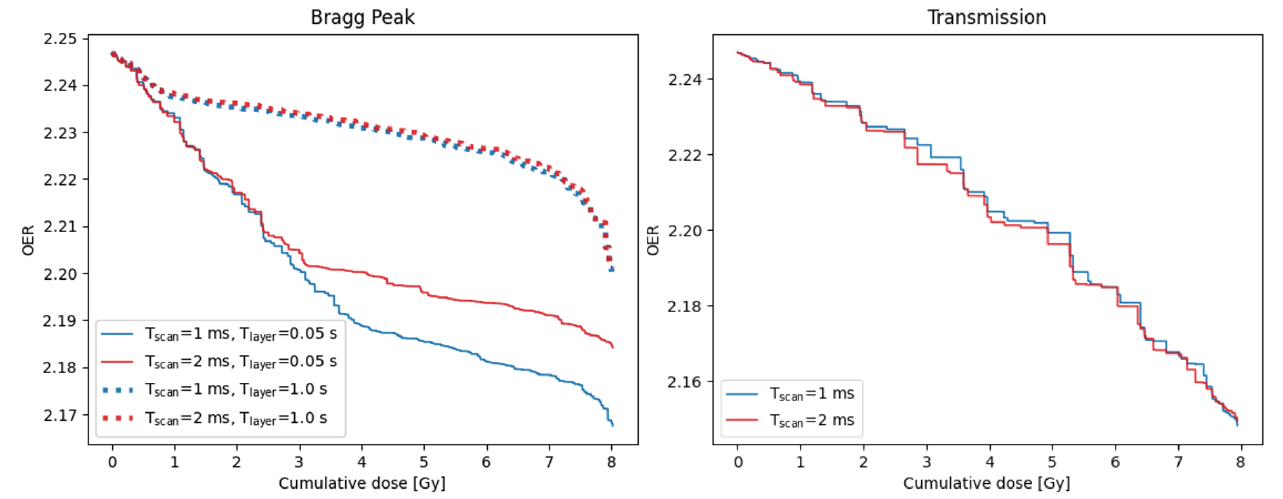
Figure 5. Dose-OER histograms calculated for a single point in the PTV of the Bragg peak ( left ) and transmission ( right ) plans shown in Figure 4, using different values of the time taken to scan between consecutive spots, T scan , and the time taken to change the energy layer, T layer . Different layer change times were not simulated for the single-layer transmission plan. Results were generated for the node 25µm from the capillary.